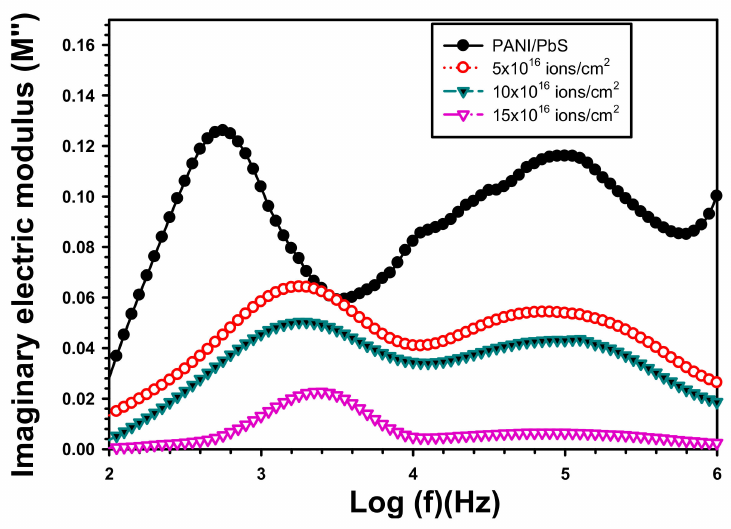
Figure 9. Electrical modulus M” with frequency for pristine and treated PANI/PbS samples.